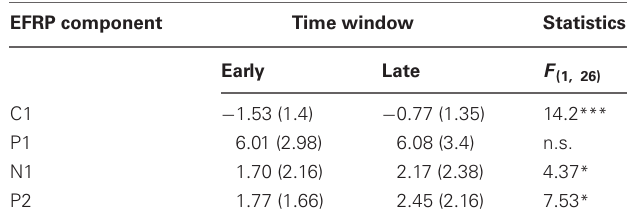
Table 1 | Mean activity of EFRP components from early and late phases during picture viewing and the univariate test statistics.